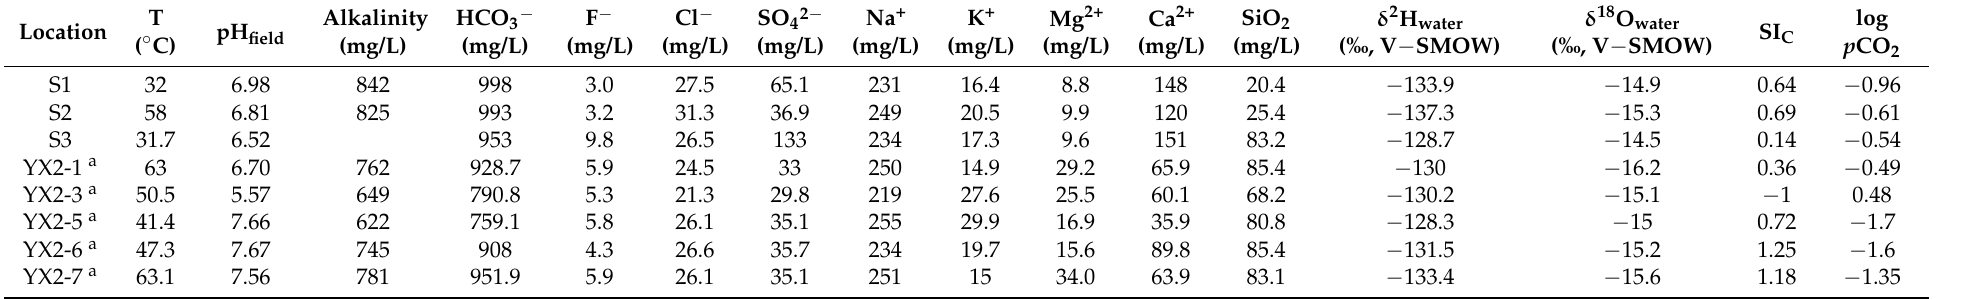
Table 1. Water chemistry, δ 2 H water and δ 18 O water values of hot springs at